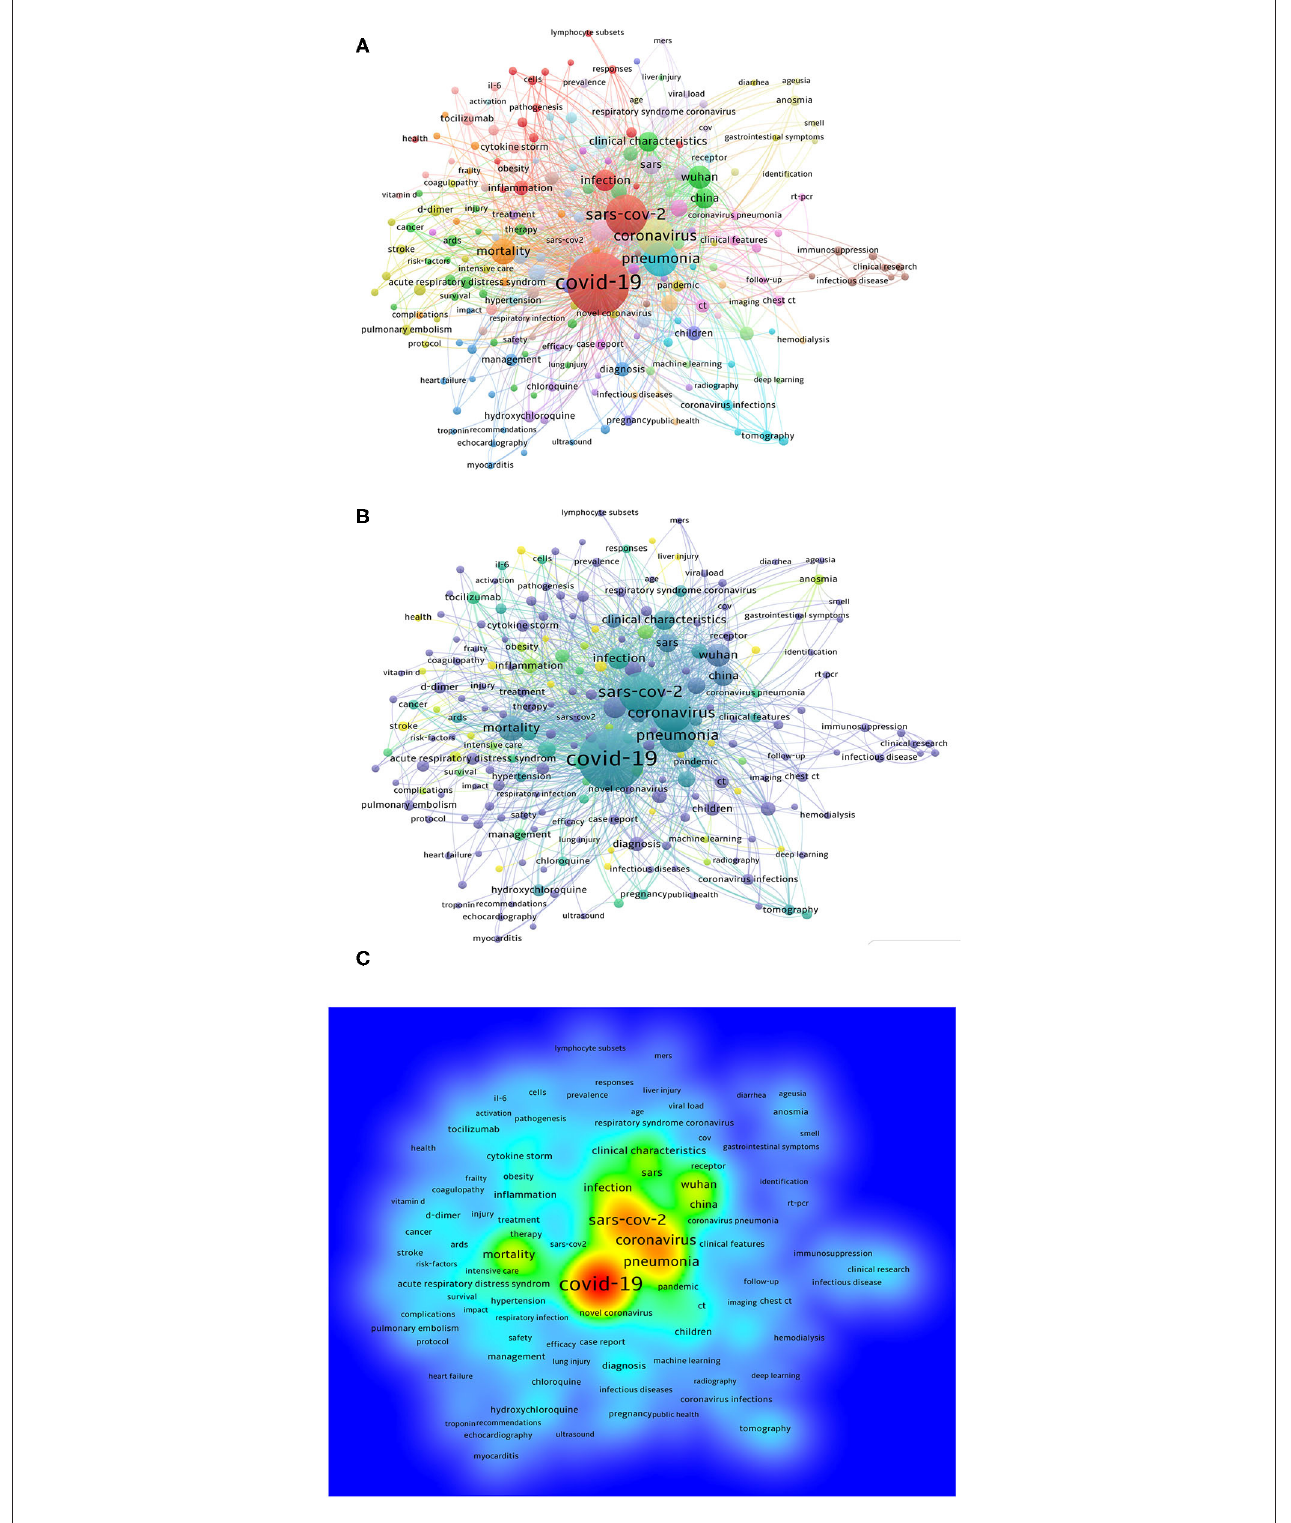
FIGURE 5 | Bibliometric analysis of keywords about clinical research publications on COVID-19. (A) Distribution of keywords. (B) Network map of trend topics according to keywords used from January 2020 to June 2020. The indicator shows current publications from purple to yellow. The size of the circles represents the frequency of appearance, whereas the distance between two circles indicates their correlation. (C) Density map of keywords.